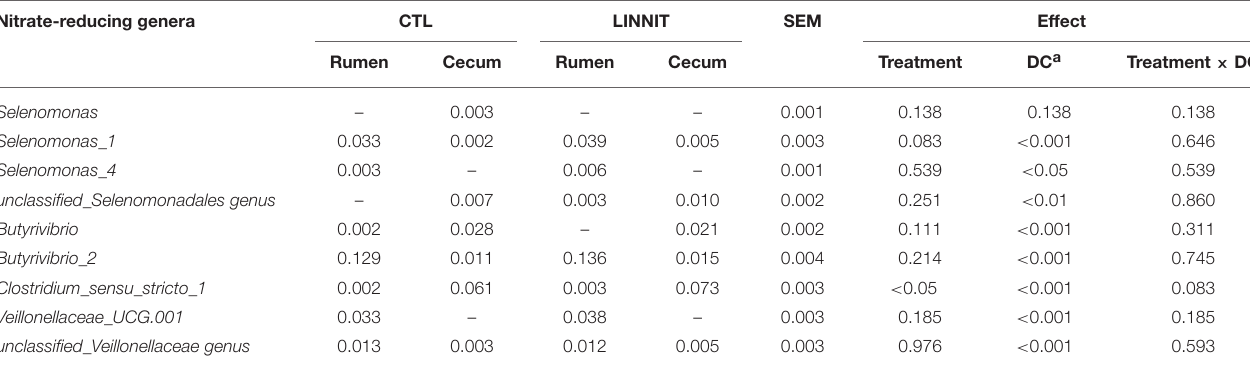
TABLE 7 | Relative abundance proportions of nitrate-reducing bacterial genera in the rumen and cecum of bulls receiving a control (CTL) or linseed plus nitrate (LINNIT) supplemented